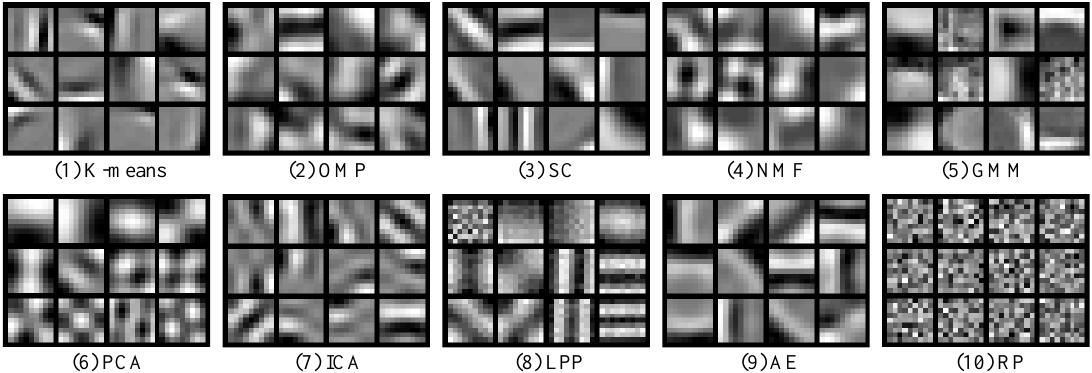
Figure 3. Examples of a set of learned filters using different unsupervised leaning methods from large quantities of image patches. Each entity of the learned basis is resized to the size of image patches (10 10 pixels). Note that the some Gabor-like filters can be achieved by K-means, orthogonal × matching pursuit (OMP), sparse coding (SC) and auto-encoder (AE). The noise-like filters shown in (10), called random projection (RP) filters [49], are generated from an independent zero-mean, unit-variance normal